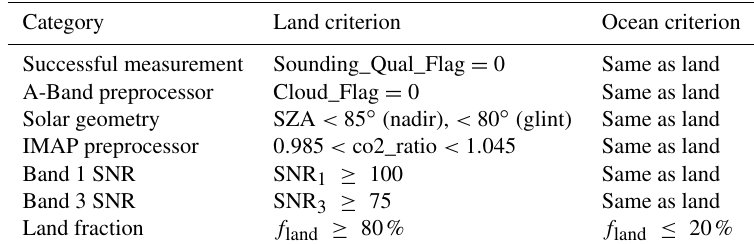
Table 1. Prescreening filter criteria.